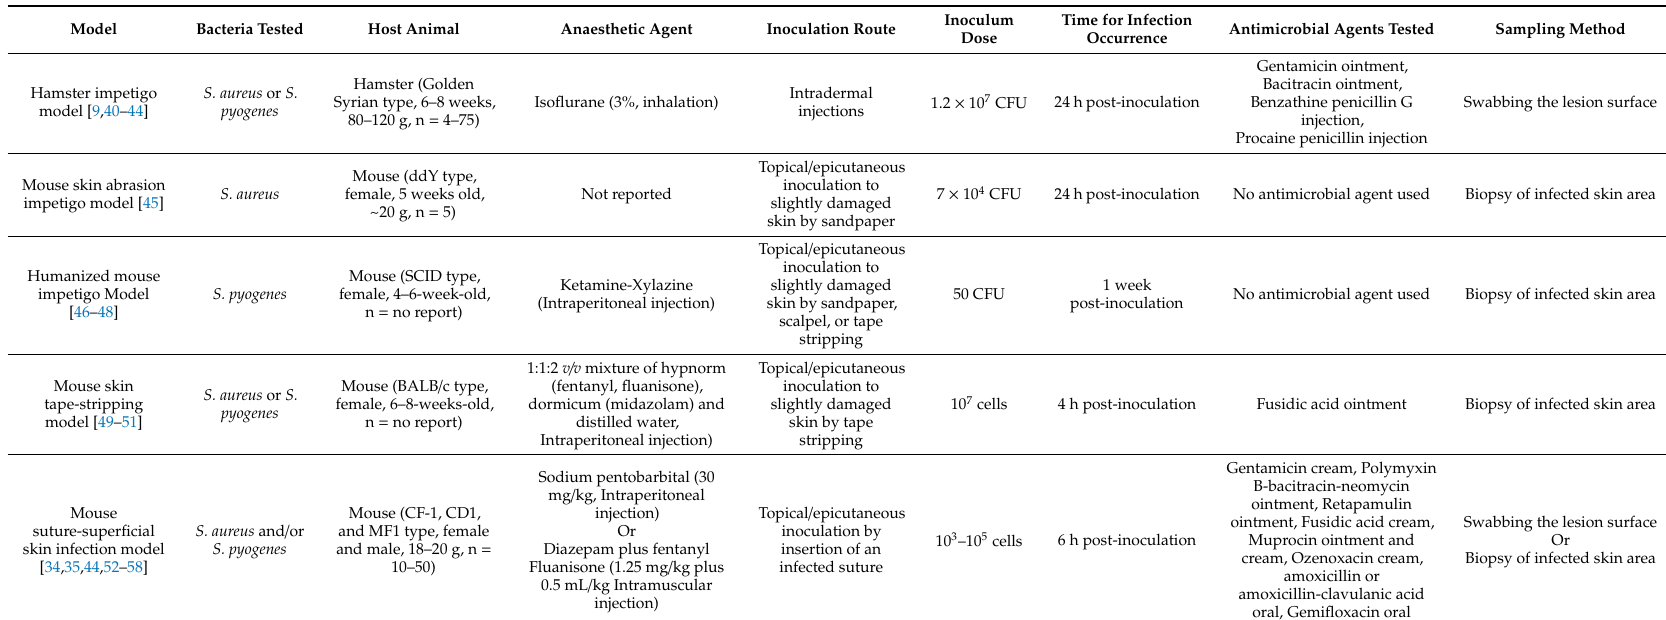
Table 1. A summary of rodent models investigated for